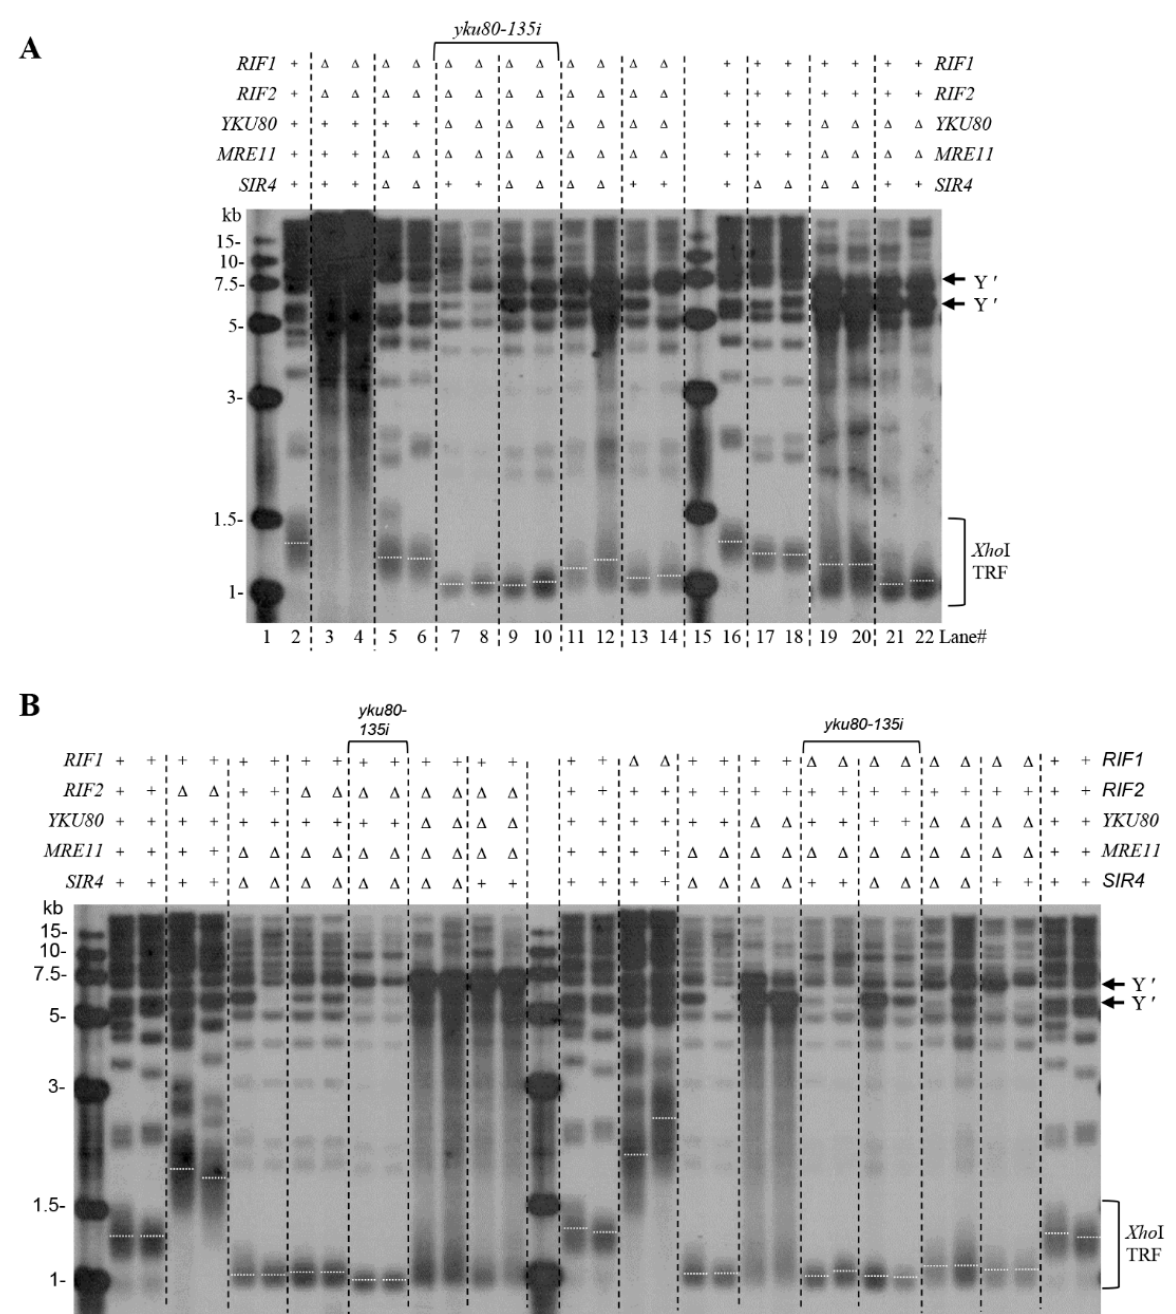
Figure 3. Telomere length analysis in various mutants with or without SIR4, RIF1, or RIF2 deletion in yku80 ∆ mre11 ∆ cells. ( A ) Spore WT, rif1 ∆ rif2 ∆ , rif1 ∆ rif2 ∆ mre11 ∆ sir4 ∆ , rif1 ∆ rif2 ∆ mre11 ∆ yku80 ∆ ( yku80-135i ), rif1 ∆ rif2 ∆ mre11 ∆ yku80 ∆ sir4 ∆ ( yku80-135i ), rif1 ∆ rif2 ∆ mre11 ∆ yku80 ∆ sir4 ∆ , rif1 ∆ rif2 ∆ mre11 ∆ yku80 ∆ , sir4 ∆ , mre11 ∆ yku80 ∆ sir4 ∆ , and mre11 ∆ yku80 ∆ . ( B ) WT, rif1 ∆ , rif2 ∆ , rif1 ∆ mre11 ∆ sir4 ∆ , rif2 ∆ mre11 ∆ sir4 ∆ , rif1 ∆ mre11 ∆ yku80 ∆ ( yku80–135i ), rif2 ∆ mre11 ∆ yku80 ∆